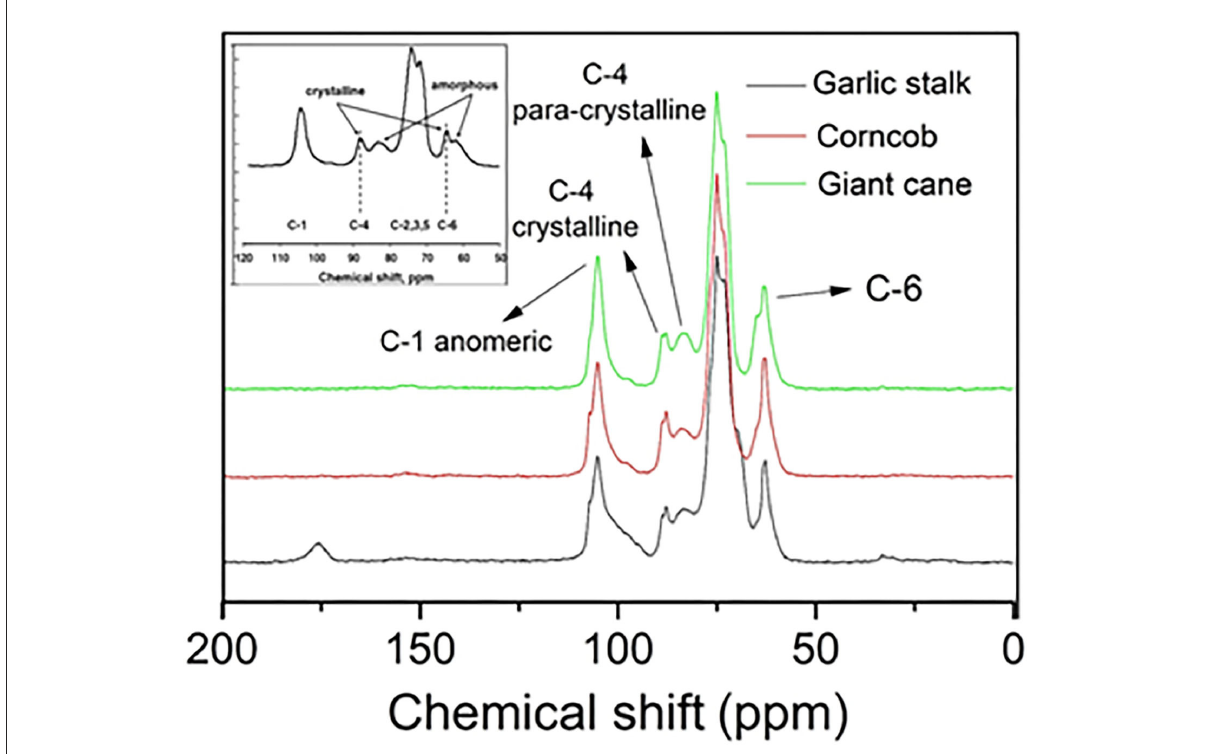
FIGURE4 13 C CP MAS solid-state NMR spectra of garlic stalk, giant cane, and corncob-derived cellulose. The insert shows the spectrum of the pure bacterial counterpart, as retrieved from the work of Park et al.